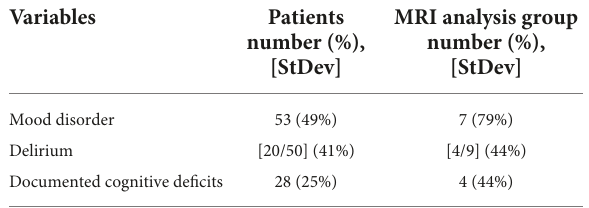
TABLE 2 Documented mood and cognitive disorders in the study